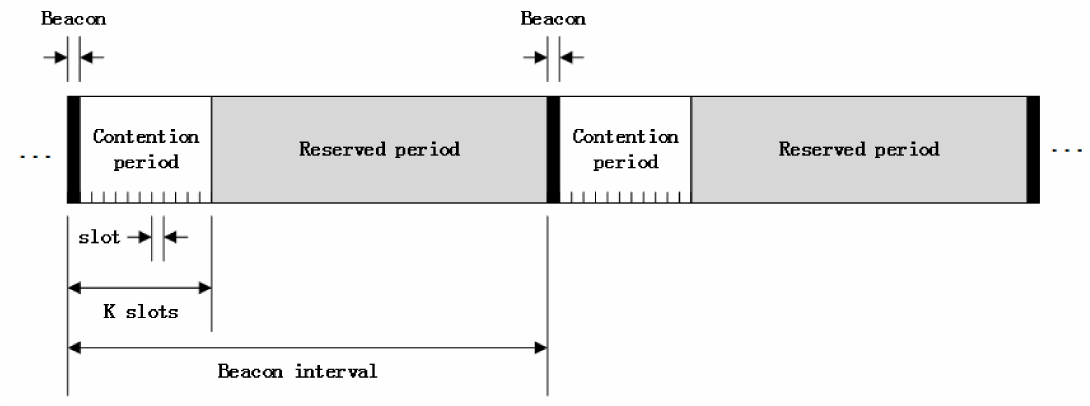
Figure 1. Beacon interval